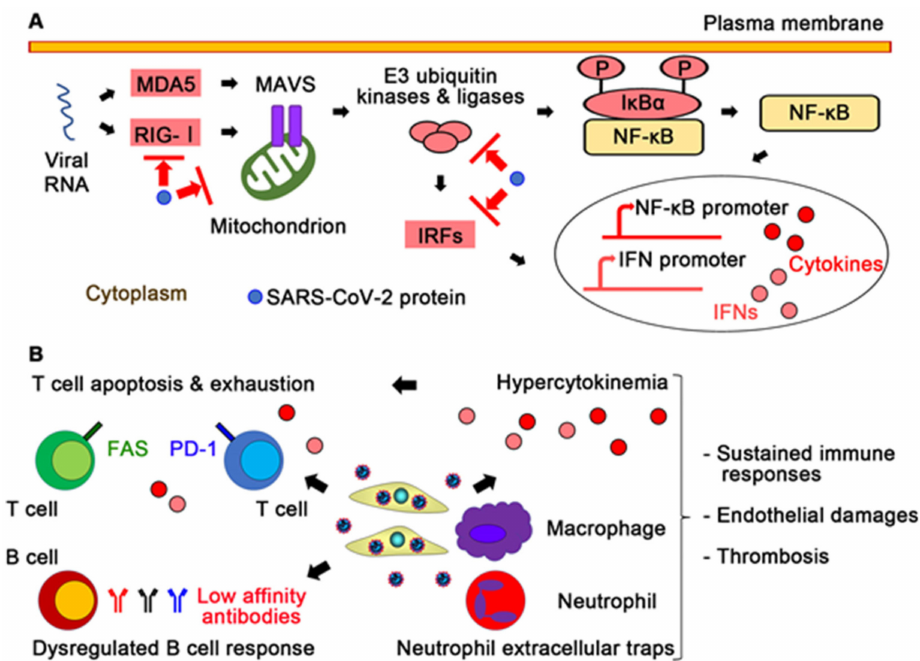
Figure 2. Dysregulated immune responses in COVID-19. ( A ) Suggested immune evasion mechanisms of SARS-CoV-2. SARS-CoV-2 proteins might inhibit pattern recognition receptors, such as retinoic acid-inducible gene I (RIG-I)-like receptors and melanoma differentiation-associated gene 5 (MDA5) and their downstream proinflammatory signaling. IFN, interferon; IRF, IFN-regulatory factor; MAVS, mitochondrial antiviral-signaling protein. ( B ) Hyperactivation of the innate immune system and suppression of the adaptive immune system in COVID-19. Persistent infection of SARS-CoV-2 induces hyperactivation of the innate immune system, subsequent hypercytokinemia, and the formation of neutrophil extracellular traps. Proinflammatory cytokines and activation-induced cell death signaling via programmed cell death protein 1 (PD-1) or the FAS receptor cause T cell apoptosis and